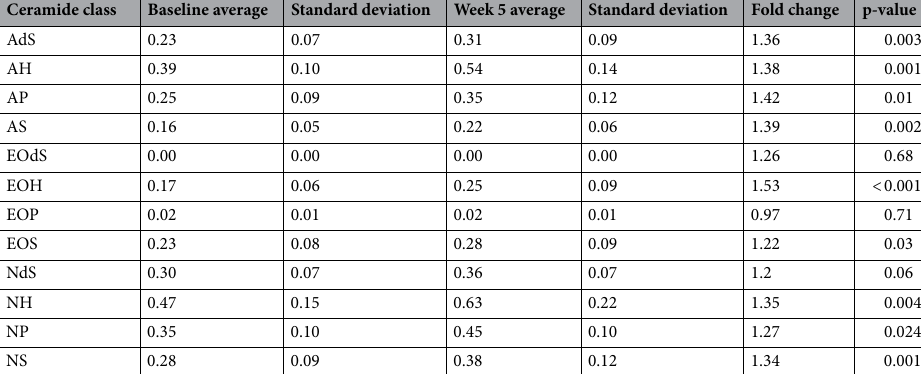
Table 2. Levels of ceramide measured per ceramide class. Average levels are given for each ceramide class in pmol/µg protein. Fold change was calculated for post intervention relative to baseline values with paired Wilcoxon testing used to assess the